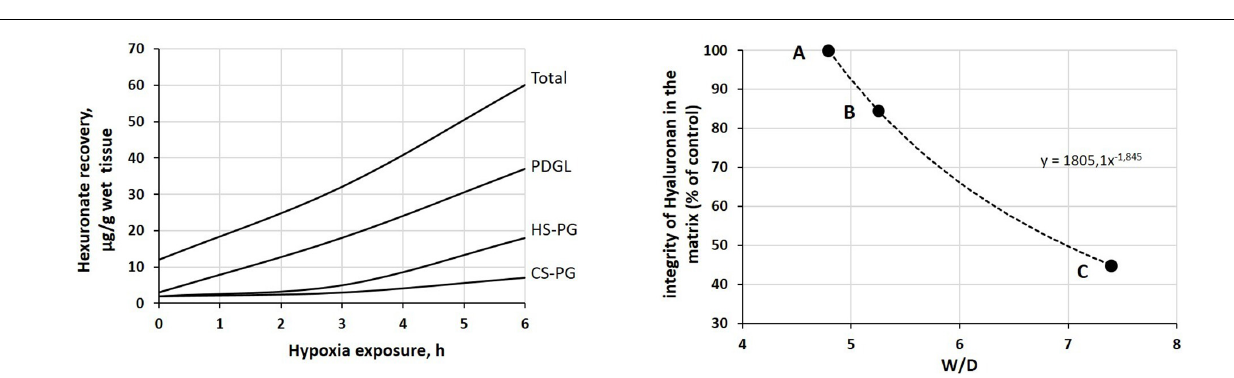
FIGURE 5 | Left: time course of the recovery of fragments of proteoglycan families upon 12% O 2 exposure (redrawn from Miserocchi et al., 2001). Peptidoglycans (PDGLs) control the permeability of the glycocalyx; heparin-sulfate proteoglycans (HS-PGs) control the permeability of endothelial and epithelial cells; chondroitin-sulfate proteoglycans (CS-PGs) provide rigidity to the interstitial matrix. Right: relationship between loss of integrity of interstitial hyaluronan (a hydrophilic non-sulfated glycosaminoglycan) and increase in W/D ratio. Points A, B, and C correspond to those reported in Figure 4